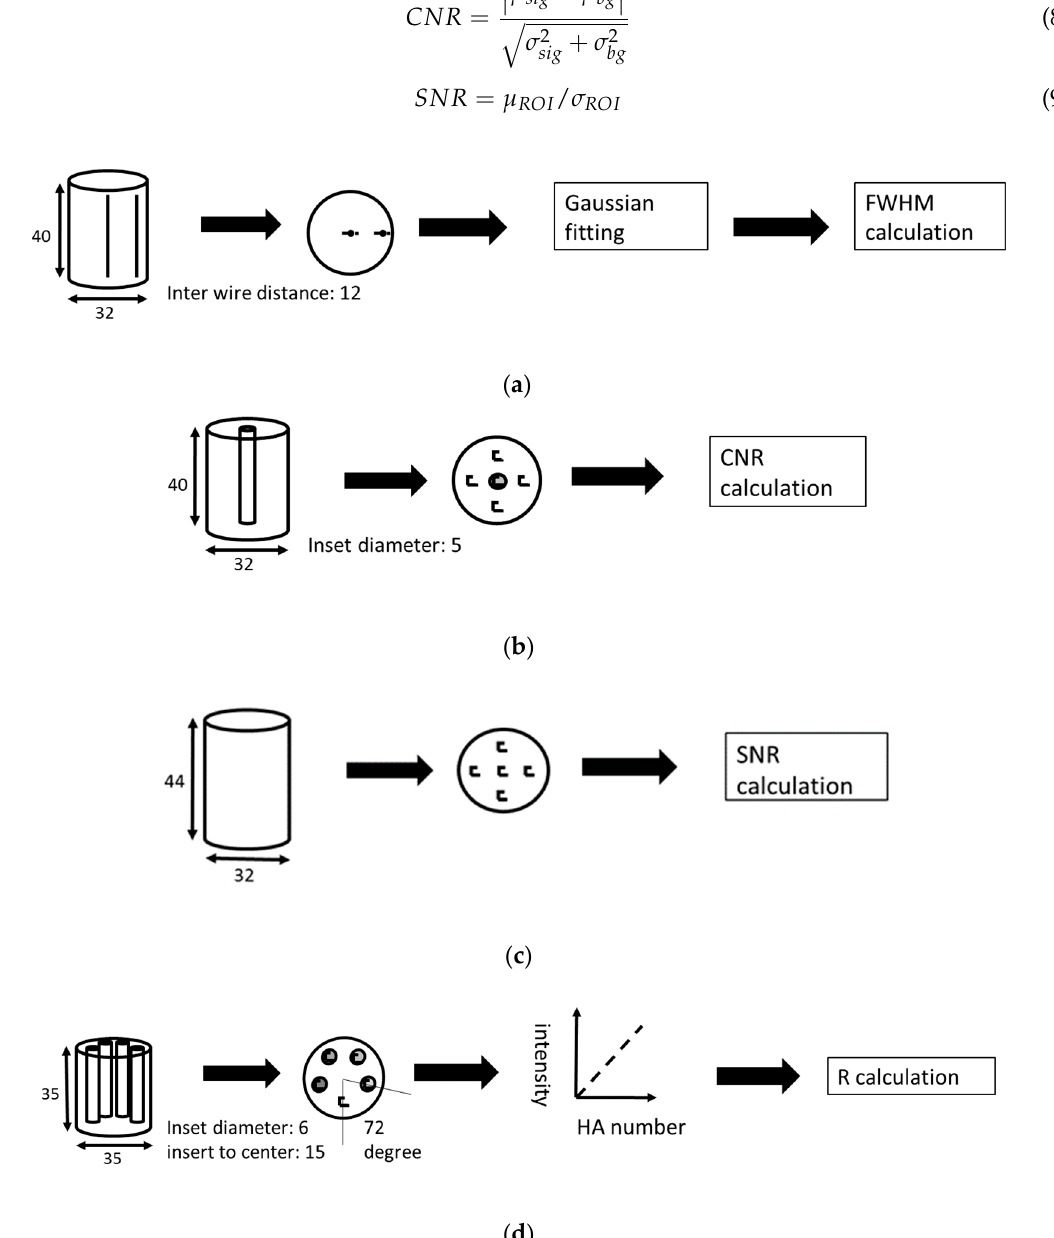
Figure 4. The procedure and evaluation method of the test phantom: ( a ) 25- μ m wire phantom, ( b ) contrast-scale phantom, ( c ) water phantom and ( d ) Hydroxyl-apatite (HA) phantom. The dashed-block areas are the regions for calculating the contrast-to-noise ratio (CNR), signal-to-noise ratio (SNR) and linearity. The size of the phantom unit is in mm. R here means the correlation coefficient.